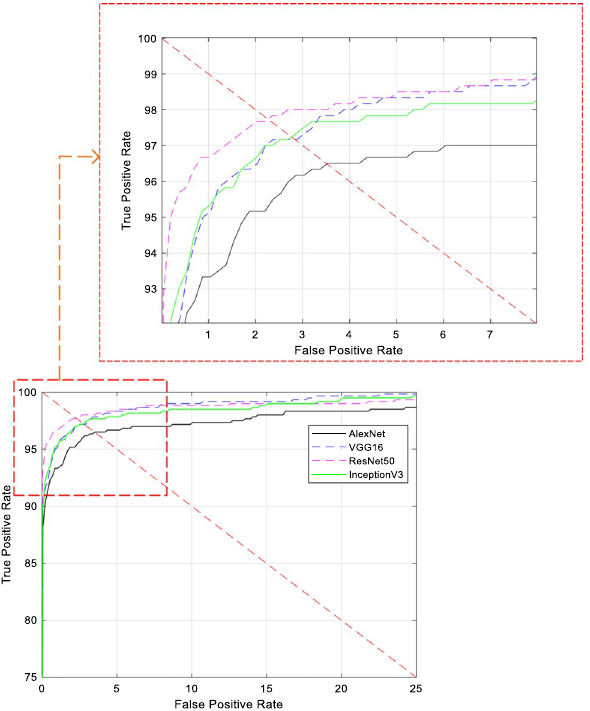
Fig. 9 ROC curve classified by the cases: case